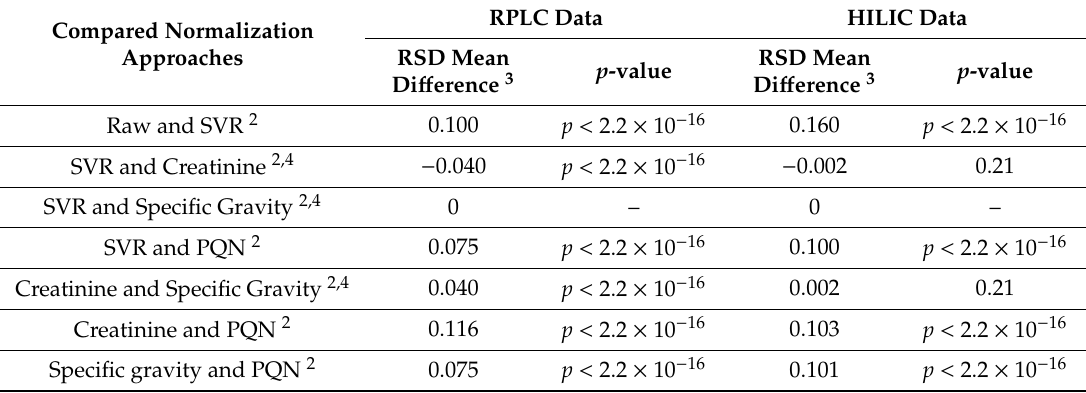
Table 2. Comparison of the mean di ff erence in relative standard deviation across quality control samples between normalization approaches using paired t -tests. 1